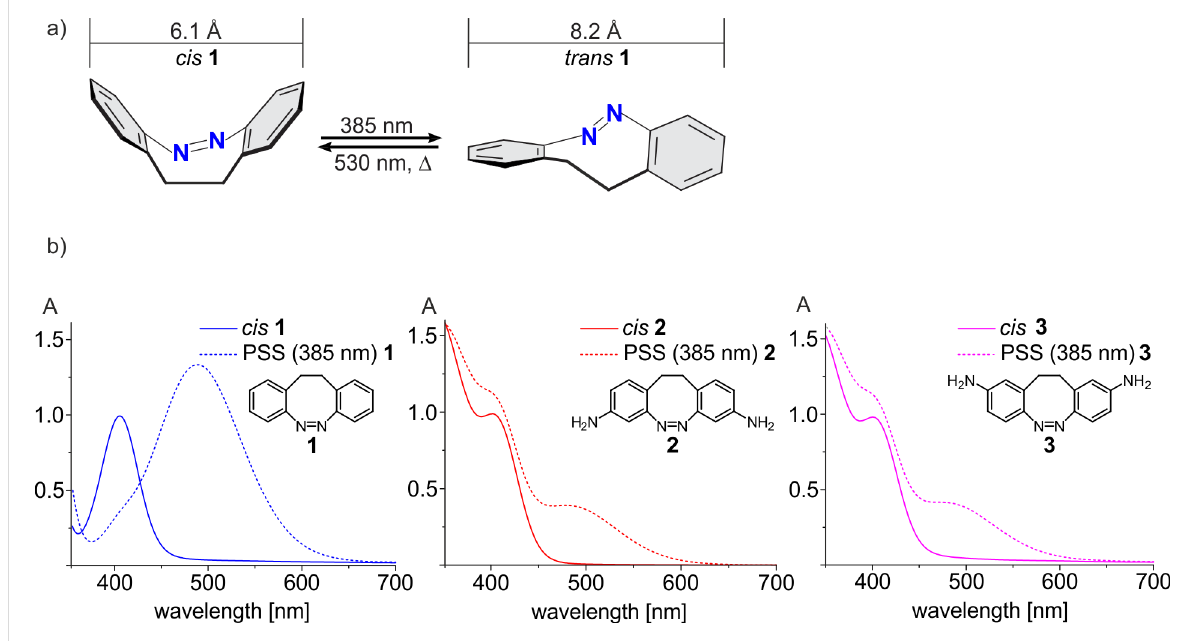
Figure 1: (a) Isomerization of parent diazocine 1 . Distances of carbon atoms para to the ethylene bridge were determined at the B3LYP/6-31g* level of DFT [23]. (b) UV–vis spectra of parent diazocine 1 (left), 3,3’-diaminodiazocine 2 (center) and 4,4’-diaminodiazocine 3 (right). Continuous lines: 100% cis and dashed lines: PSS (385 nm) at 298.15 K in acetonitrile.